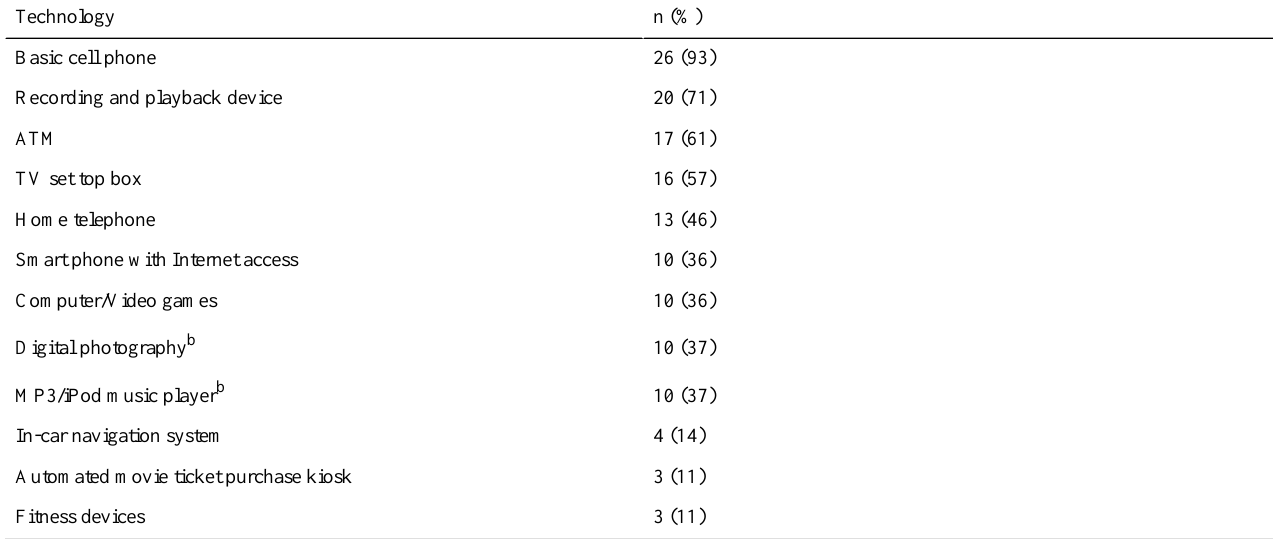
Table 4. Use of technology (N=28) of participants who use “frequently”. a